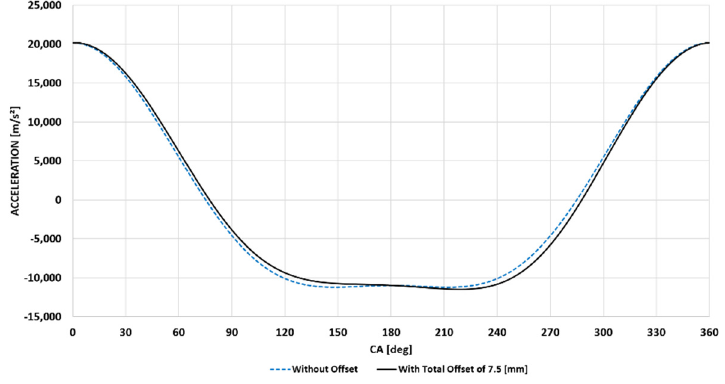
Figure 3. Piston acceleration curve of crankshaft with and without 10 mm offset towards the major thrust side.